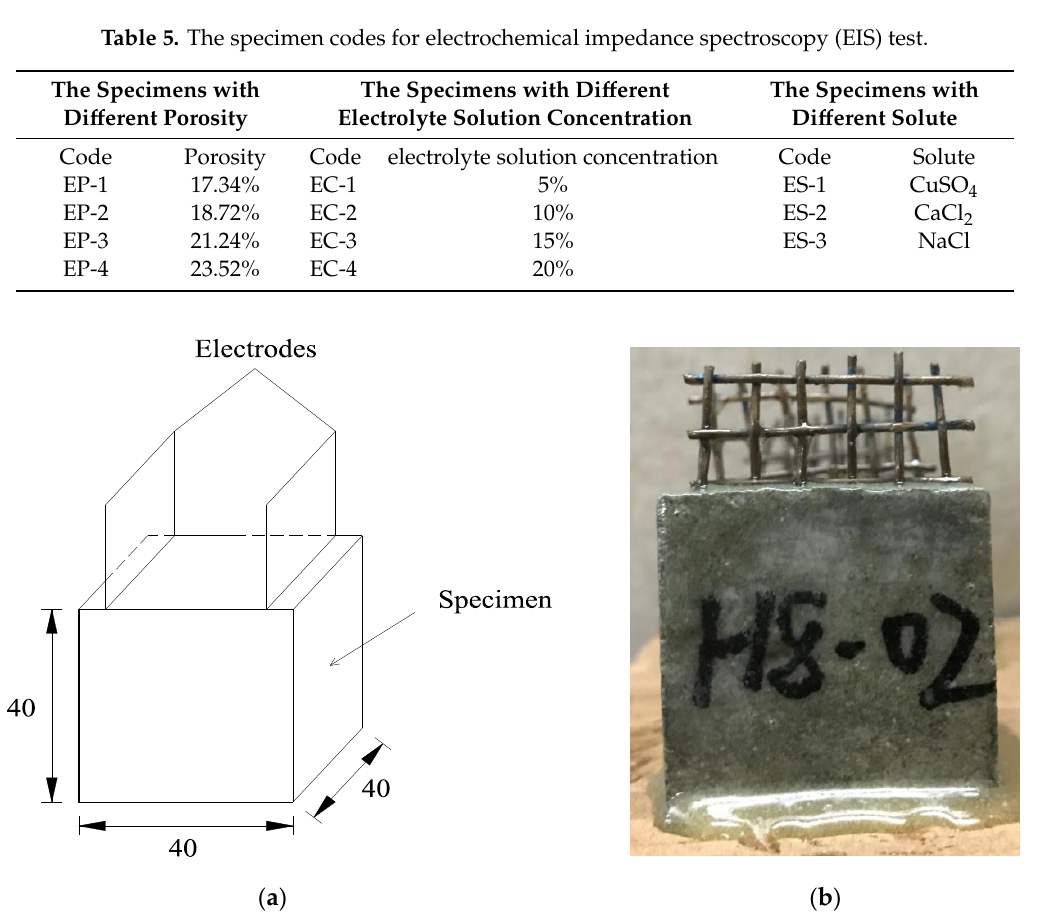
Figure 1. Typical ionically conductive mortar. ( a ) the dimension of specimen ( b ) photo of